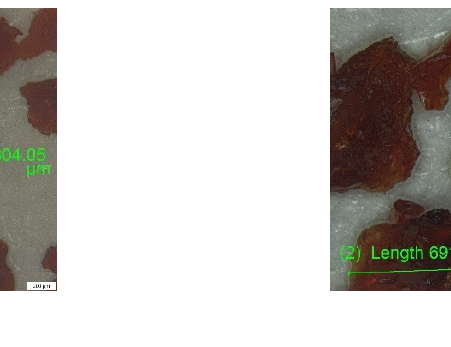
Figure 9. Optical microscopy analysis for CS microbeads: ( a ) 50× and ( b ) 100× magnification.